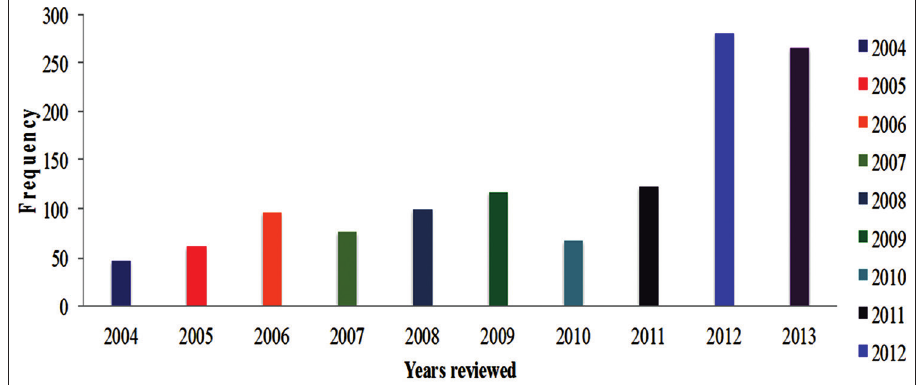
Figure-3: Occurrence of bovine Tuberculosis among slaughtered cattle in Bauchi municipal abattoir, Nigeria